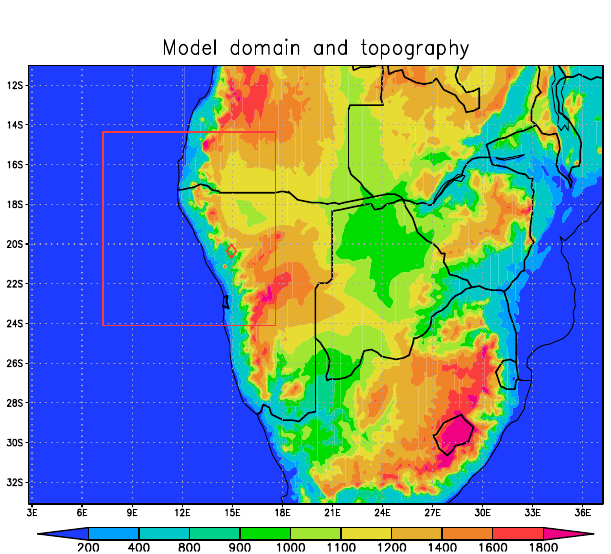
Figure 1. The 9 km model domain, and the 3 km domain in a red rectangle. The shaded contours indicate the terrain (m).